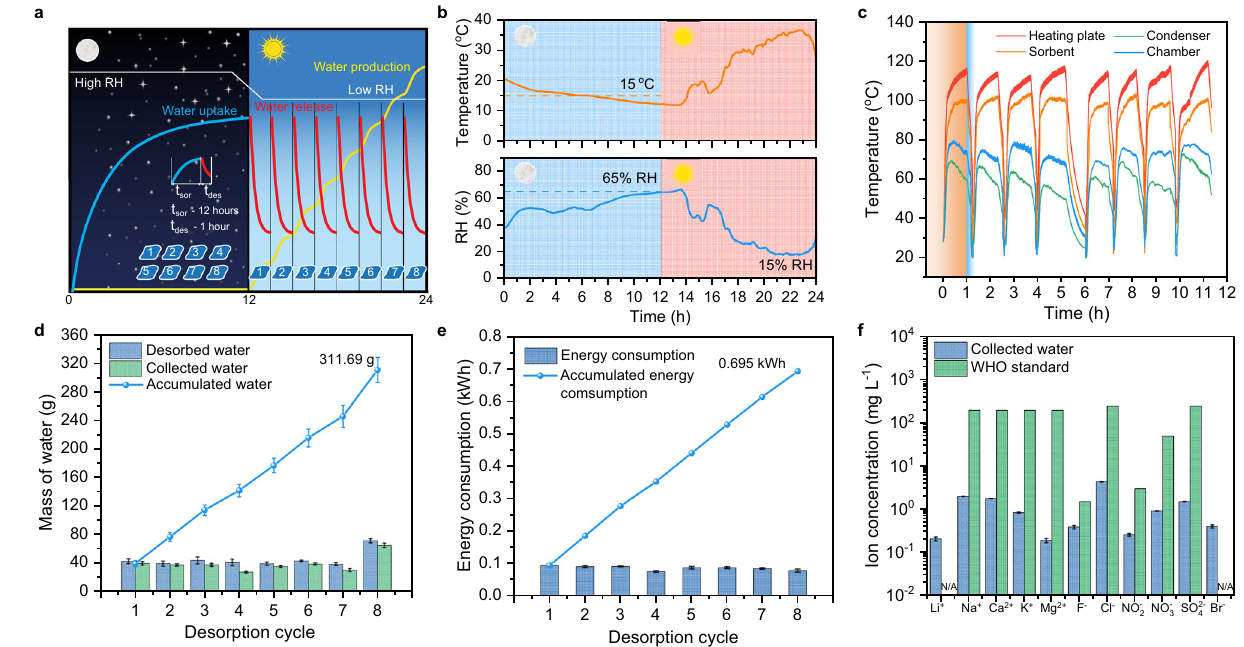
Fig. 4 | Water harvesting performance of the water harvester by applying the batch-processed alternating mode.a Schematicdiagramoftheproposedbatch- processed alternating mode, showing the variation of water capture, release, and production in a single diurnal cycle. The eight pieces of sorbents are simulta- neously exposed to the high RH ambient during the night, and consequent batch- operation desorption releases water vapor with freshwater production during the daytime. The white, blue, red, and yellow lines represent RH variation, water uptake,waterrelease,andwaterproductionoverthewholeday,respectively. b Air